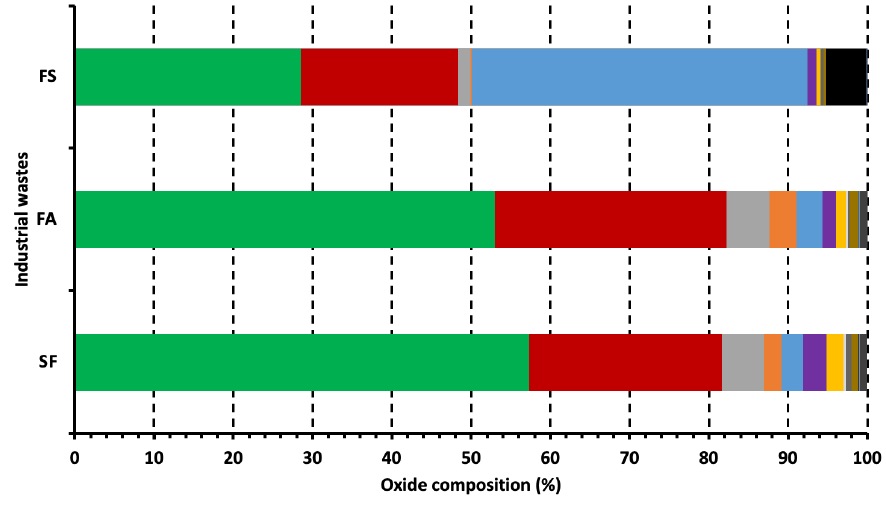
Figure 6. Chemical composition of industrial wastes.